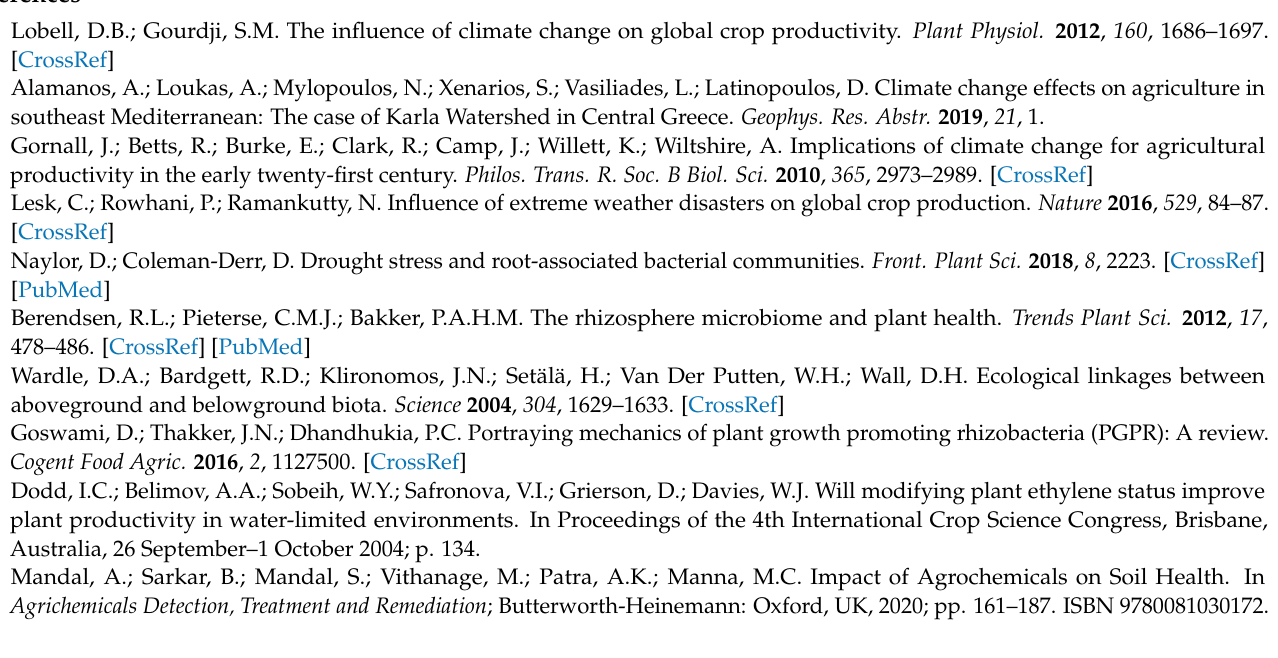
soil enzyme activity. Table S3: p -values of ANOSIM analysis based on Bray-Curtis index applied on values of individual PLFAs, Figure S1: Mean values ( ± SE) of urease and β -glucosidase activity in soil samples of L. sativa under different water regimes (5 and 10% soil water